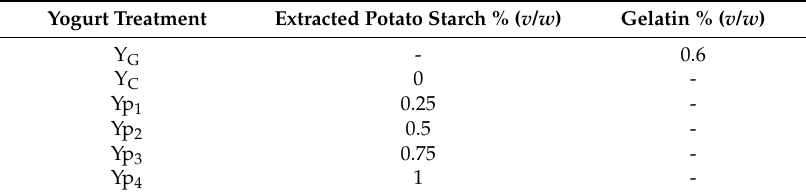
Table 1. The work plan within the optimized